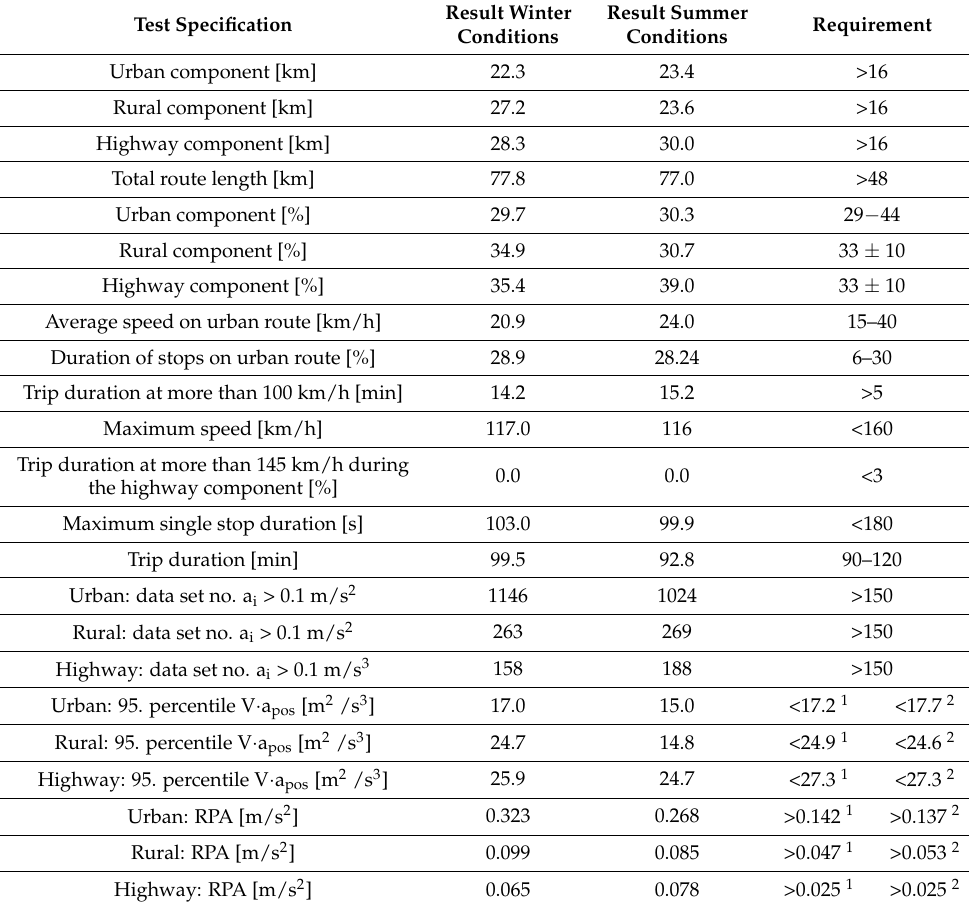
Table 3. Meeting real driving emissions (RDE) test requirements for summer and winter performed measurements